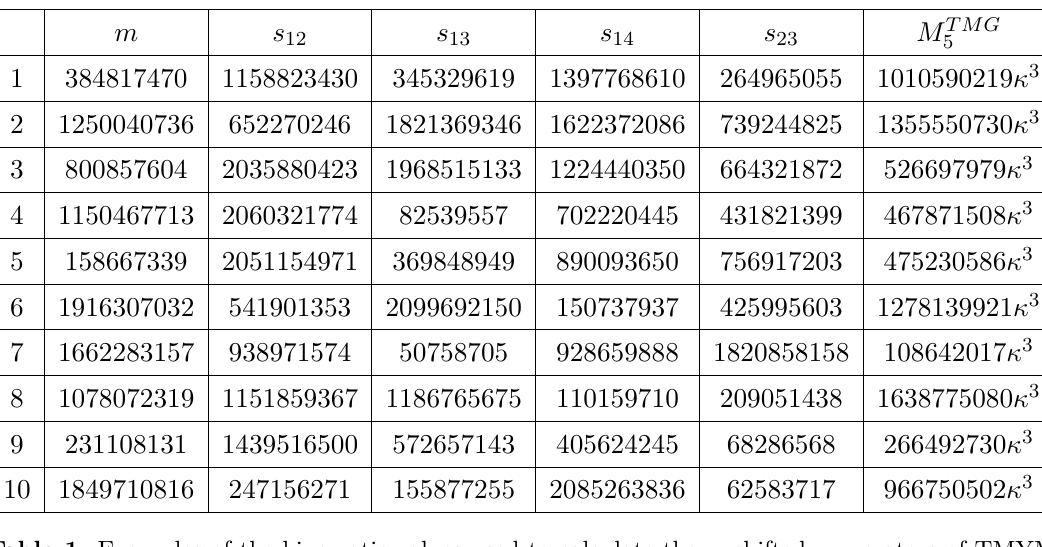
Table 1 . Examples of the kinematic values used to calculate the unshifted numerators of TMYM and the 5-point TMG. The values are in the field of integers modulo p = 2147483497 . The remaining Mandelstam variable, s , can be obtained by requiring that (3.6) is zero in 3D. 24